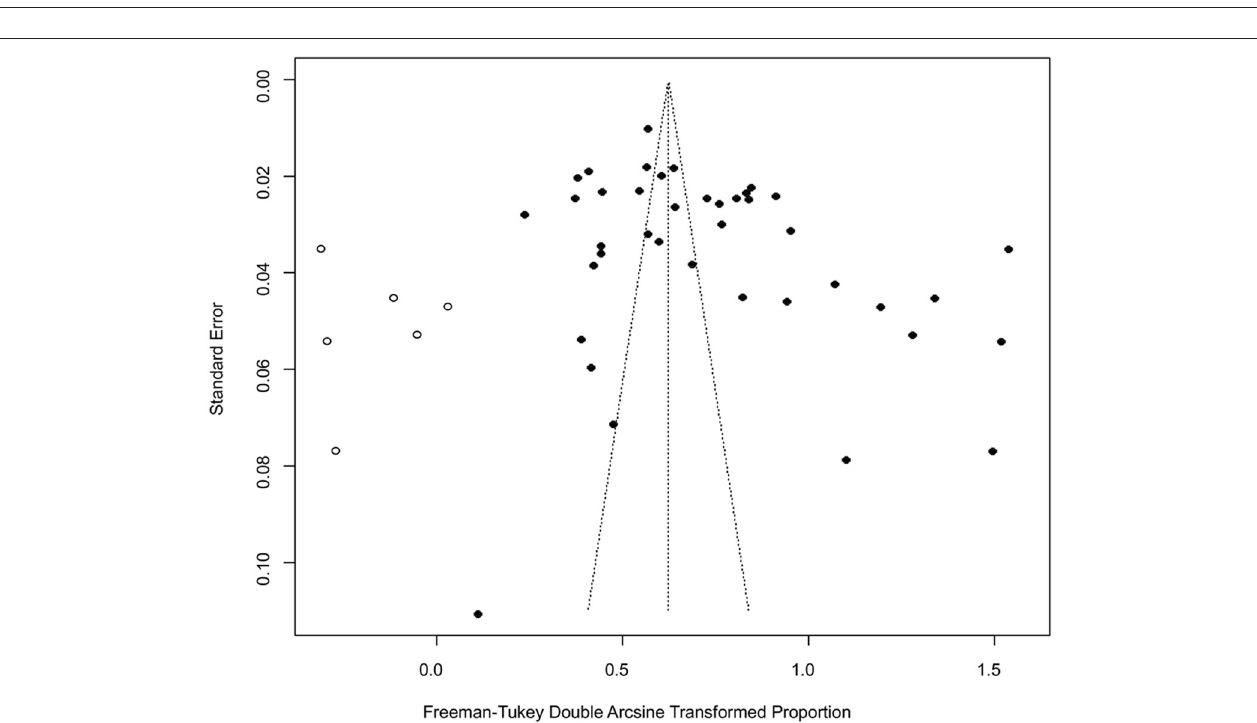
FIGURE 5 | Funnel plot with trim and filling analysis of the publication bias. rate were not included in fish species sampled from South China Sea (71). In addition to fish species, differences in prevalence may be associated with fishing grounds (15). For example, previous